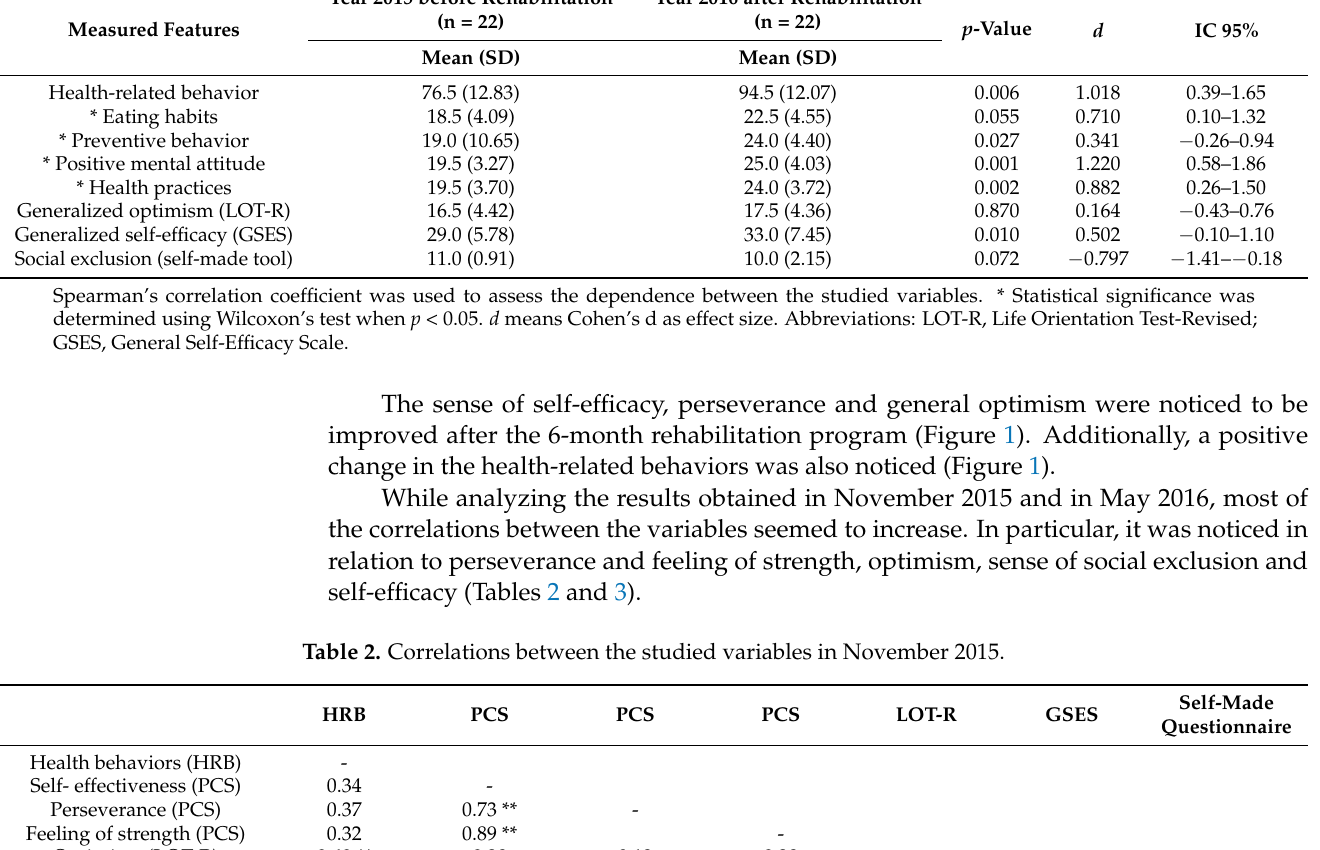
Measured Features